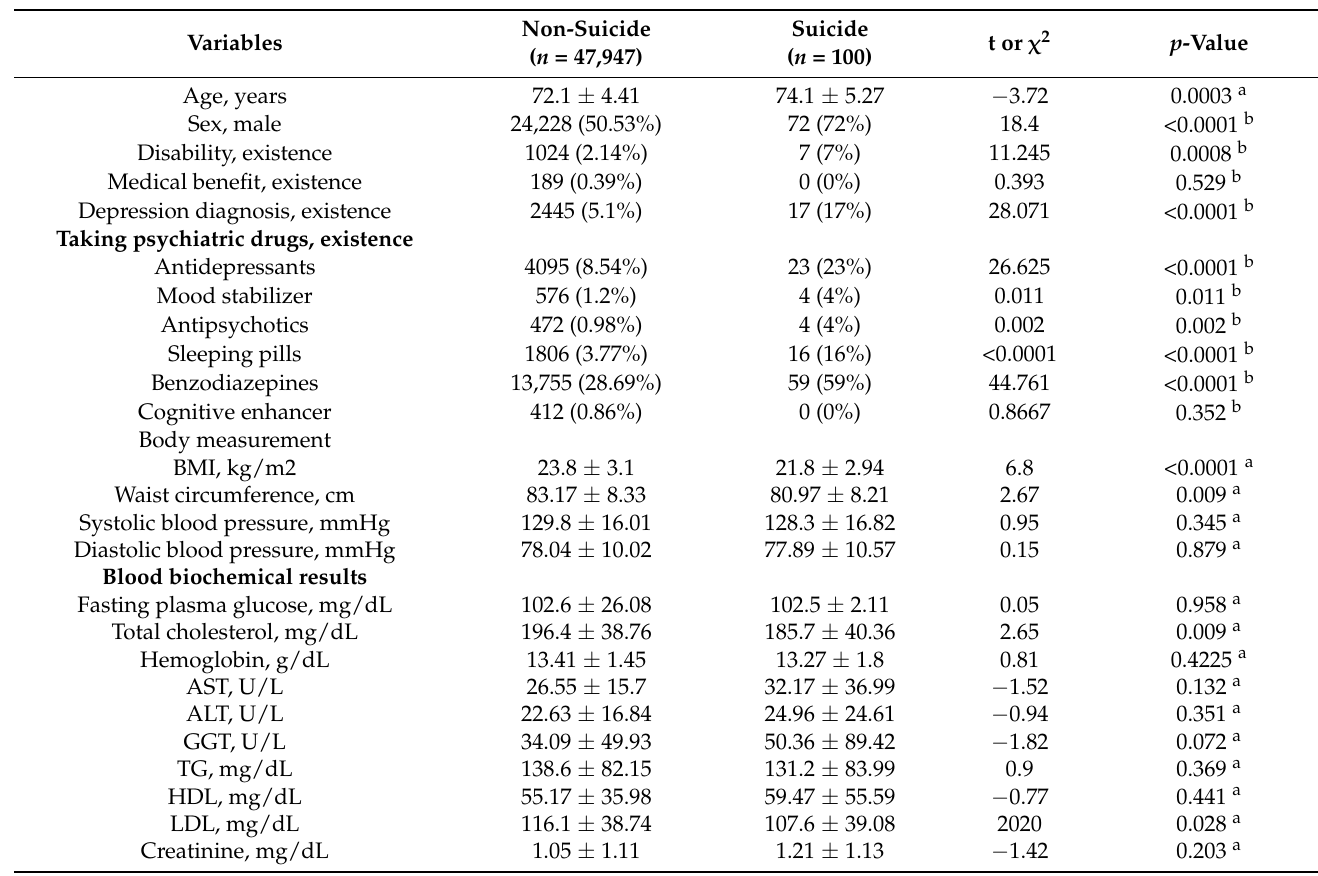
Table 1. Comparison of sociodemographic and economic characteristics and medical use between suicide and non- suicide